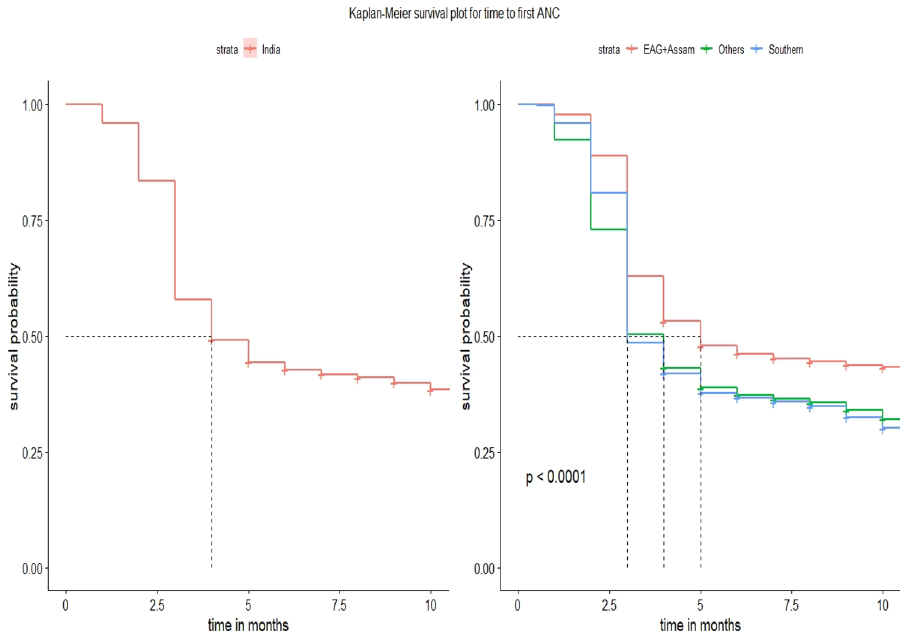
Figure 2. Kaplan–Meier survival estimate of pregnant women for time to first ANC visit, India and its specific regions, 2016. ( Source: NFHS-4, 2015–2016